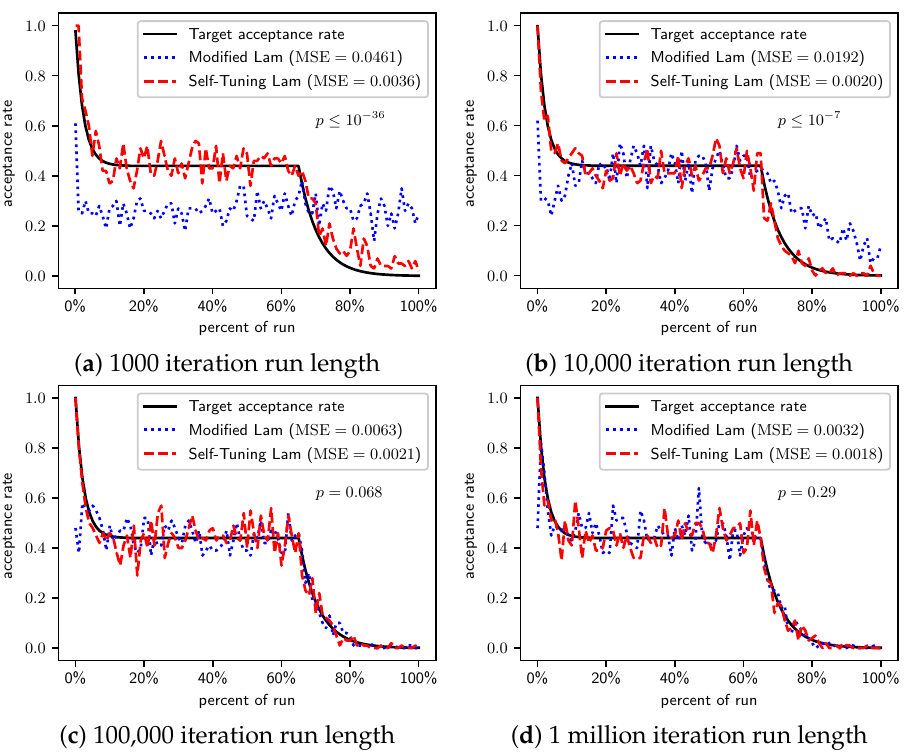
Figure 9. Minimize f 1,10 ( x ) : Self-Tuning Lam, Modified Lam, and target acceptance rates for